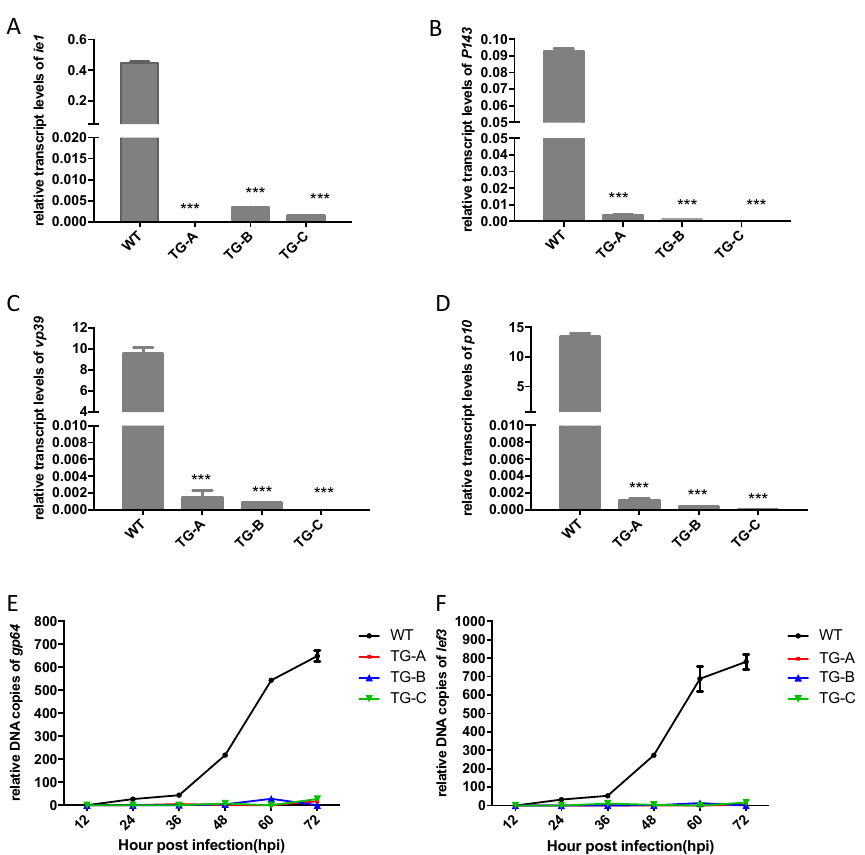
Figure 6. NPV transcription and replication are inhibited in transgenic silkworms. ( A – D ) Expression levels of ie1 ( A ), p143 ( B ), vp39 ( C ), and p10 ( D ) transcripts at 60 hpi in the transgenic and WT silkworms infected with 10 6 OBs/larva of BmNPV. Transcript levels were determined relative to levels of BmRp49 . Data are means ± SEM. *** p < 0.001 by one-way ANOVA. ( E , F ) Relative numbers of copies of viral DNA from the regions of gp64 ( E ) and lef3 ( F ) in the transgenic and WT silkworms at different points after viral inoculation with 10 6 OBs/larva.